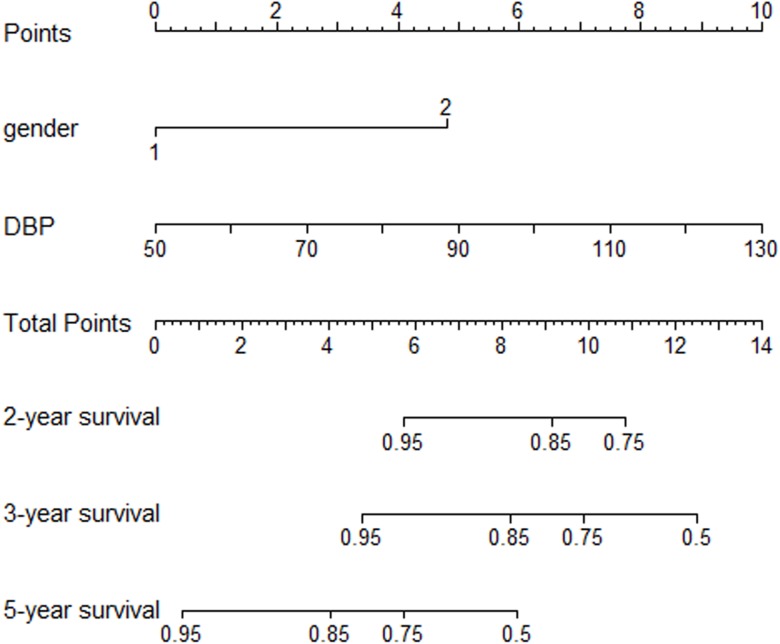
IgAN patients’ relapse nomogram.To use the nomogram, an individual patient’s value is located on each variable axis, and a line is drawn upward to determine the number of points received for each variable value. The sum of these numbers is located on the Total Points axis, and a line is drawn downward to the survival axes to determine the likelihood of 2-,3- or 5-year IgAN relapse.